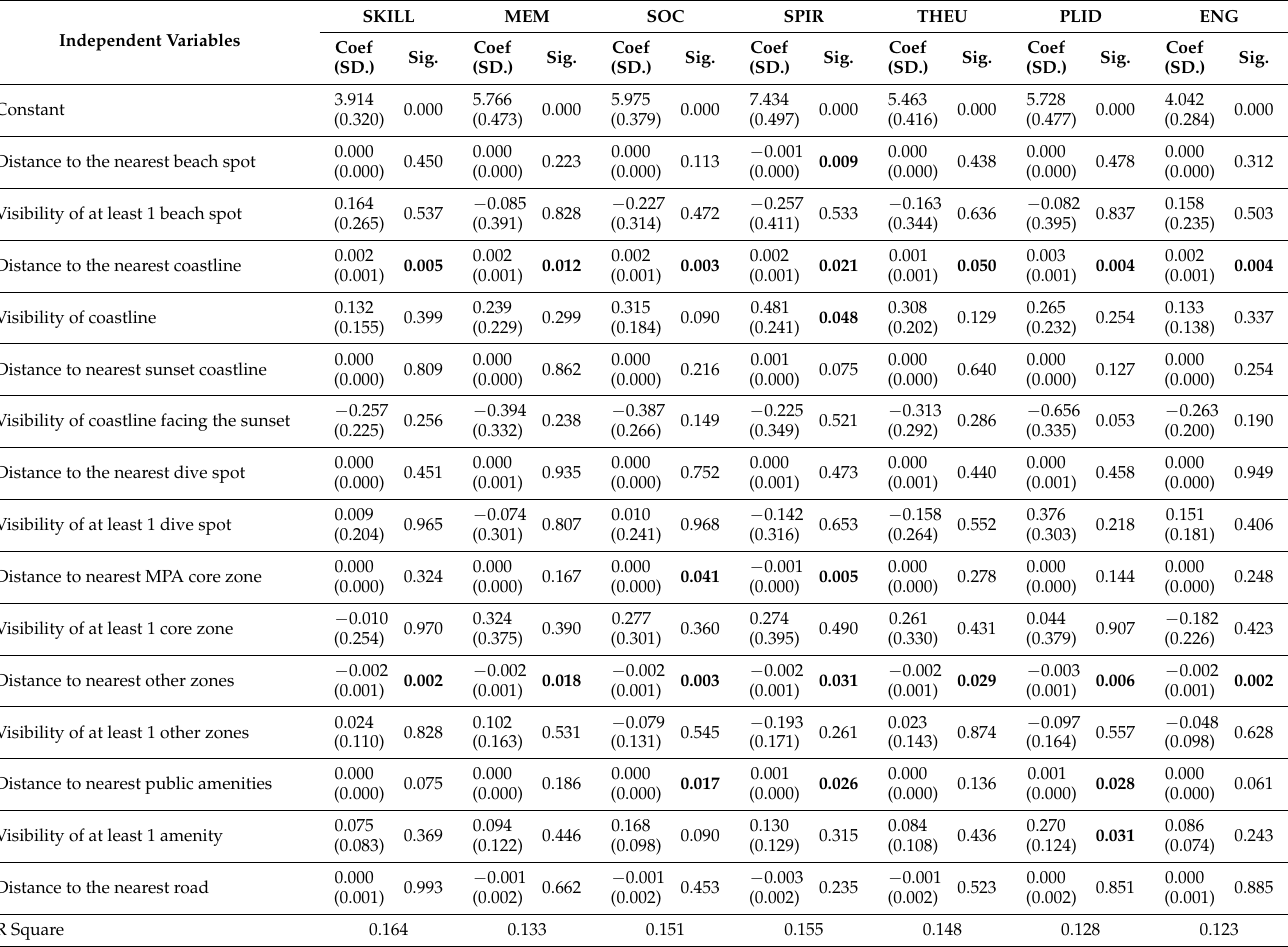
Table 4. Summary of multiple regression results between CES well-being dimensions and marine tourism and protection